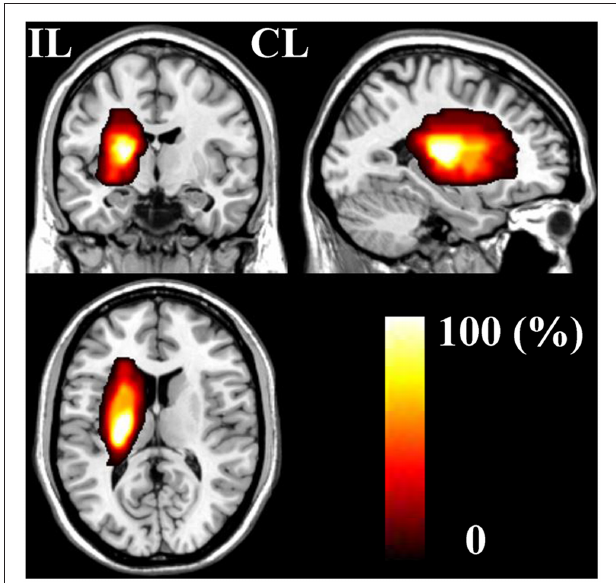
FIGURE 1 | The stroke patient lesion incidence map . CL, contralesional; IL, ipsilesional.